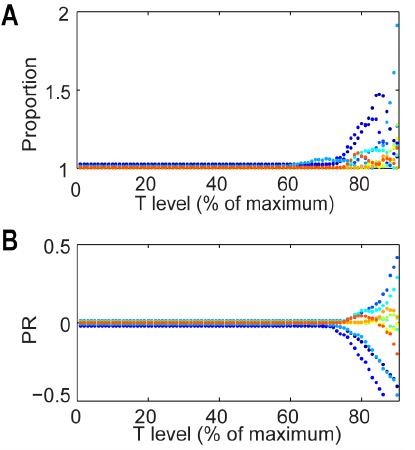
Figure 2. Ratio coefficients from experimental data are dependent on the threshold value. Fluorescence intensity ratios were extracted from images of dividing MLA cells expressing GFP, and for a random selection of 10 events, ratios plotted again threshold setting. Ratios were calculated using Proportion ( A ) and PR ( B ). Different colors represent different events.